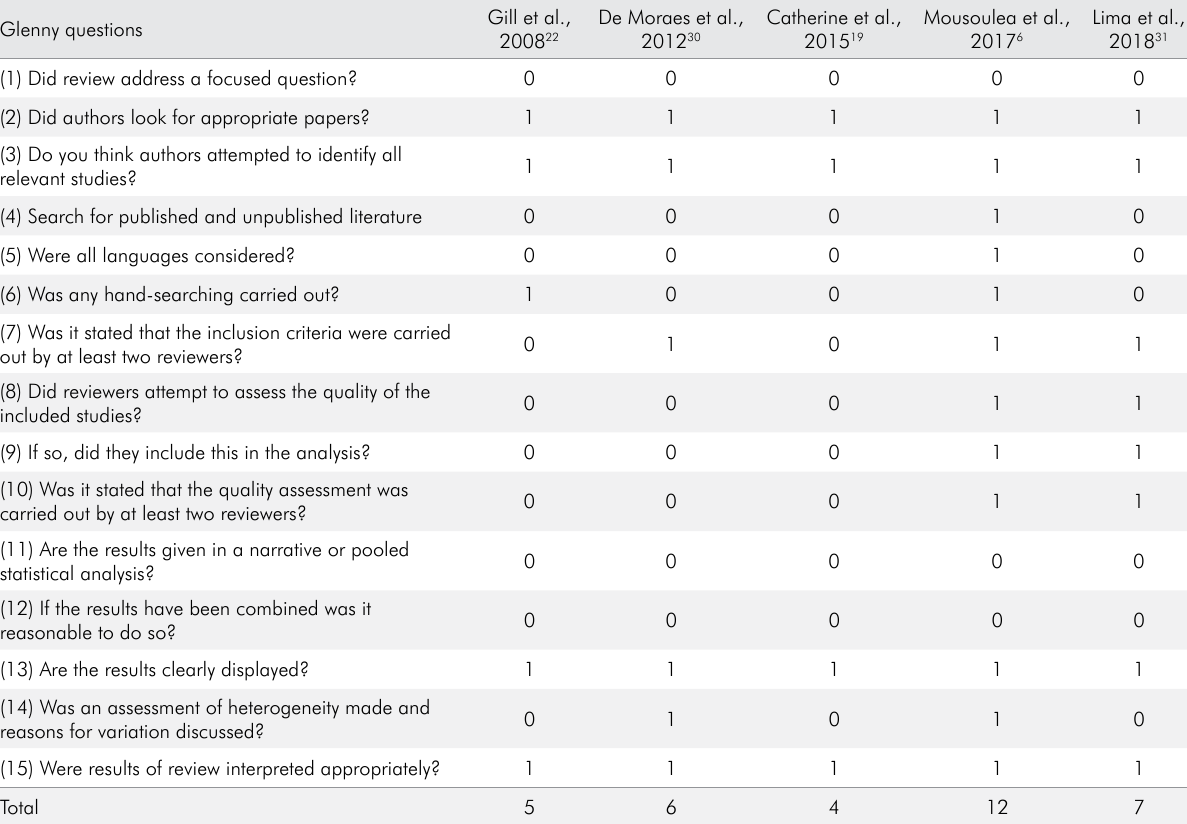
Table 4. Assessment of systematic reviews using Glenny